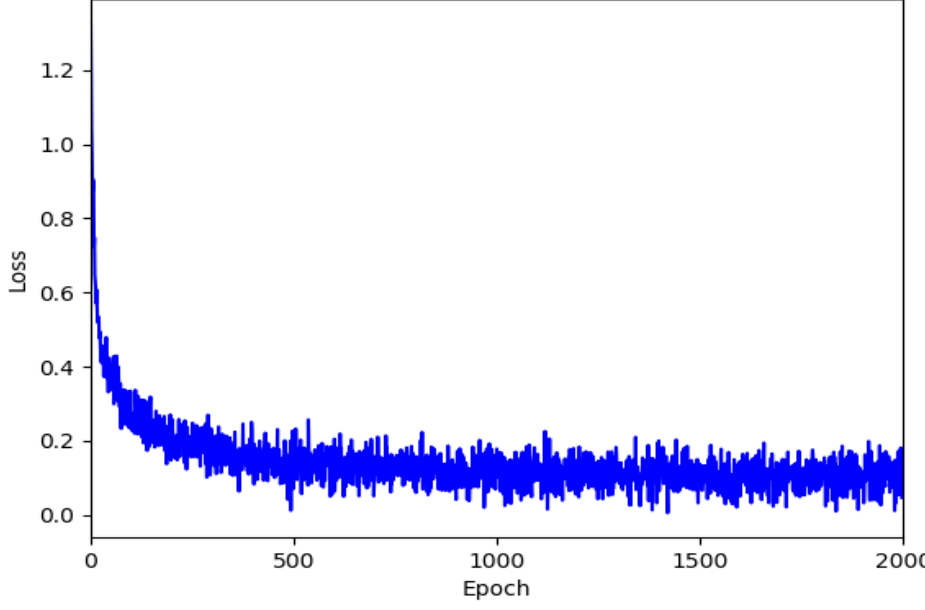
Figure 7. Loss value according to epoch for NYU Depth Dataset V2.